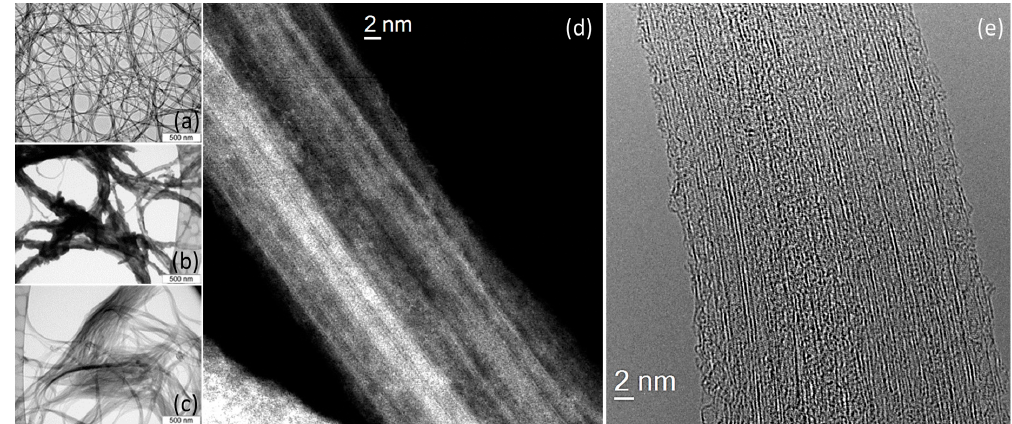
Figure 1. TEM images of initial SWCNTs ( a ), SWCNT / S-1 ( b ) and SWCNT / S-2 ( c ). HAADF-STEM ( d ) and HRTEM ( e ) images of a bundle of SWCNT / S-2.